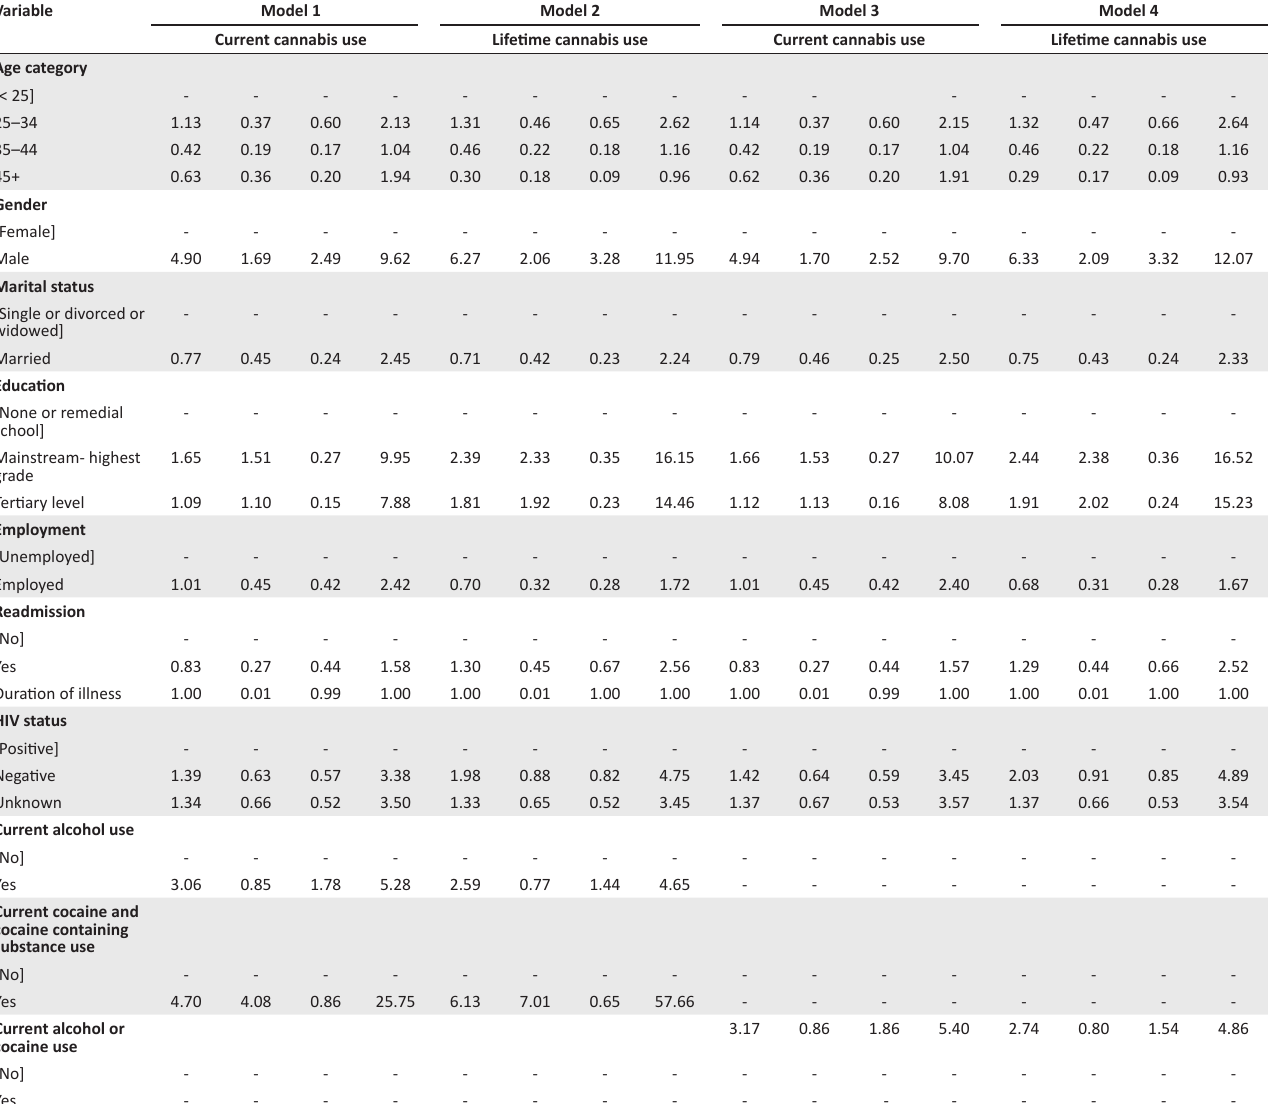
TABLE 3: Logistic regression: Association between socio-demographic and clinical variables of people admitted with schizophrenia spectrum and other psychotic disorders and cannabis